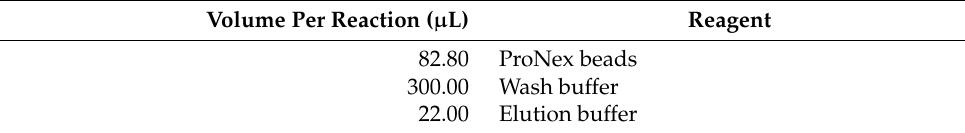
Table 7. RNA-Primer Mix for Reverse Transcription.